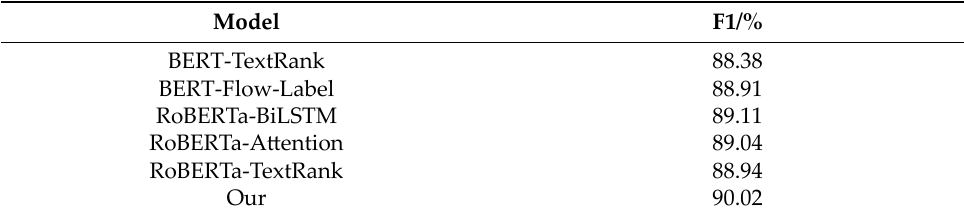
Table 5. Experimental results on CCKS2020 dataset.